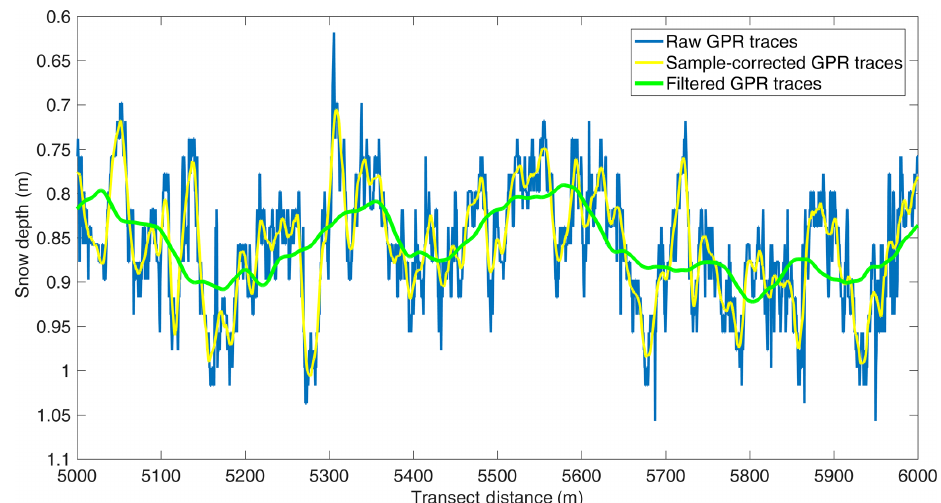
Figure 2. A 1km section of radar-derived snow depths for the end-of-melt-season 2016 horizon of the radar transect from May 2017 at DYE-2. Displayed are the raw first breaks (blue line), the depths after being corrected for sample uncertainties (yellow line) and the final product being used to assess spatial variability for an area of several square kilometers (green